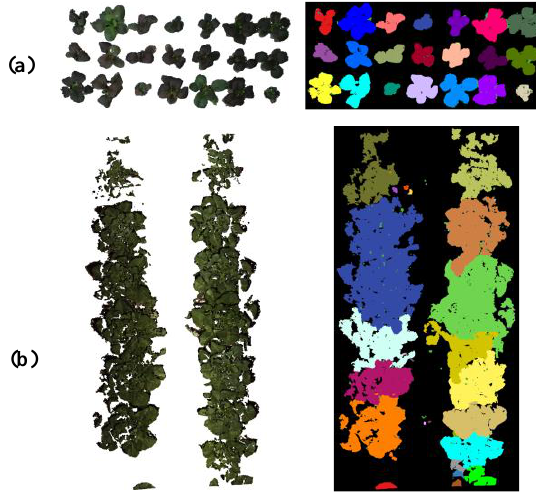
Figure 10. The individual segmentation result of new experimental data. ( a ) the data in the first row were acquired by our platform in the greenhouse, ( b ) the data in the second row were published by Mortensen et al. [26] and acquired by stereo-configuration. The accuracies calculated by Equation (5) were 100% and 61.54%, respectively.